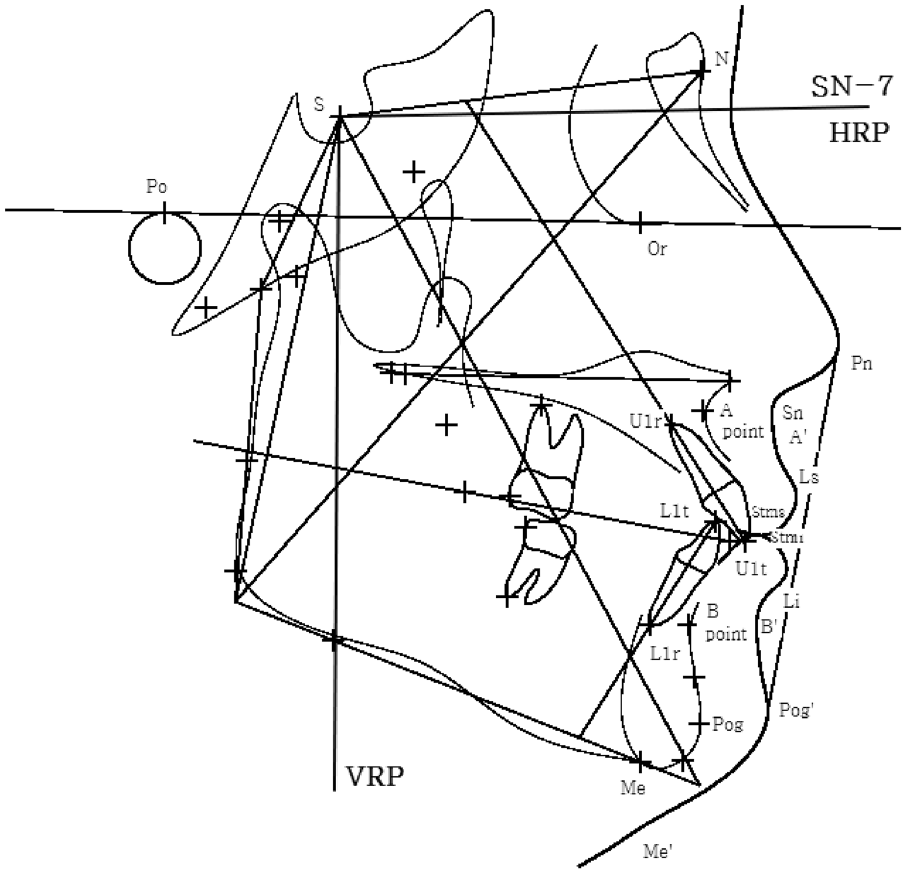
Figure 3. Reference lines and points for cephalometric analysis. Horizontal reference plane (HRP) is line minus 7° from the Sella–Nasion line. Individual landmarks are as follows: sella (S), nasion (N), A point (A), B point (B), pogonion (Pog), menton (Me), root apex of the maxillary central incisor (U1r), tip of the maxillary central incisor (U1t), tip of the mandibular central incisor (L1t), root apex of the mandibular central Incisor (L1r), pronasale (Pn), subnasale (Sn), soft tissue A point (A ′ ), labrale superioris (Ls), stomion superioris (Stms), stomion inferioris (Stmi), labrale inferioris (Li), soft tissue B point (B ′ ), soft tissue pogonion (Pog ′ ), soft tissue menton (Me ′